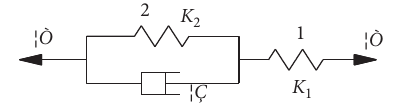
Figure 4: Kelvin–Voigt model. 1, Hook model; 2, Kelvin